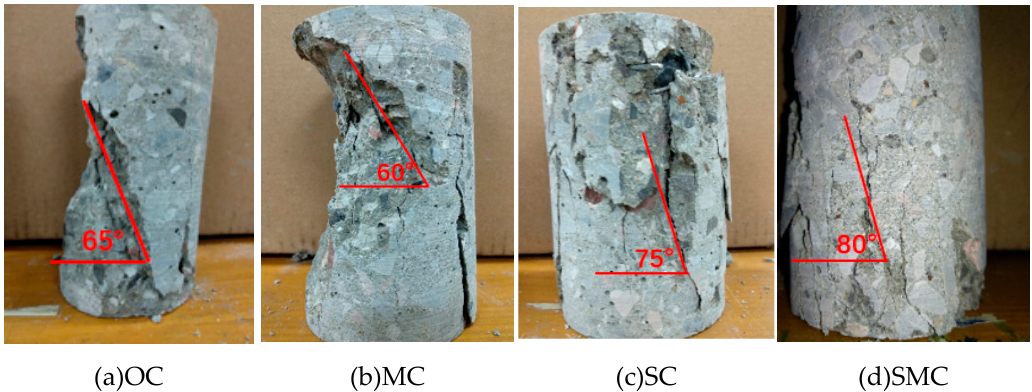
Figure 5. Failure pattern of concrete. ( a ) OC, ordinary concrete; ( b ) MC, MgO concrete; ( c ) SC, steel fiber-reinforced concrete; ( d ) SMC, steel fiber-reinforced MgO concrete.